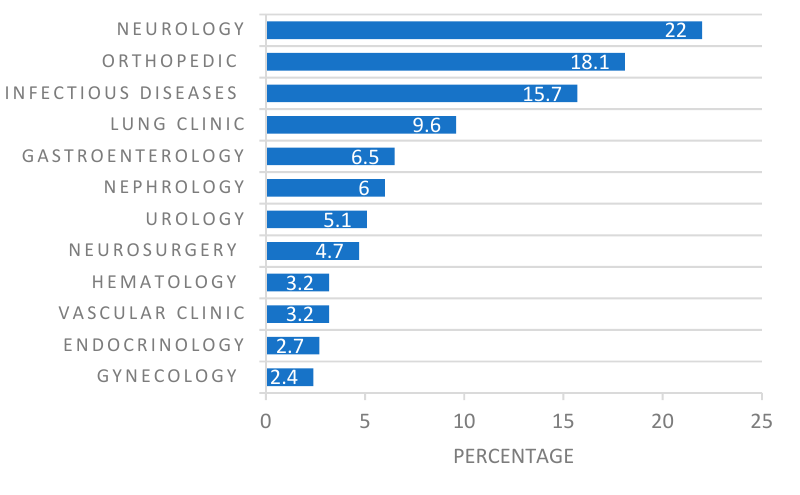
Figure 1. Distribution of inpatient falls (percentage) among included clinics in relation to the total number of falls ( n = 870) during 2018.